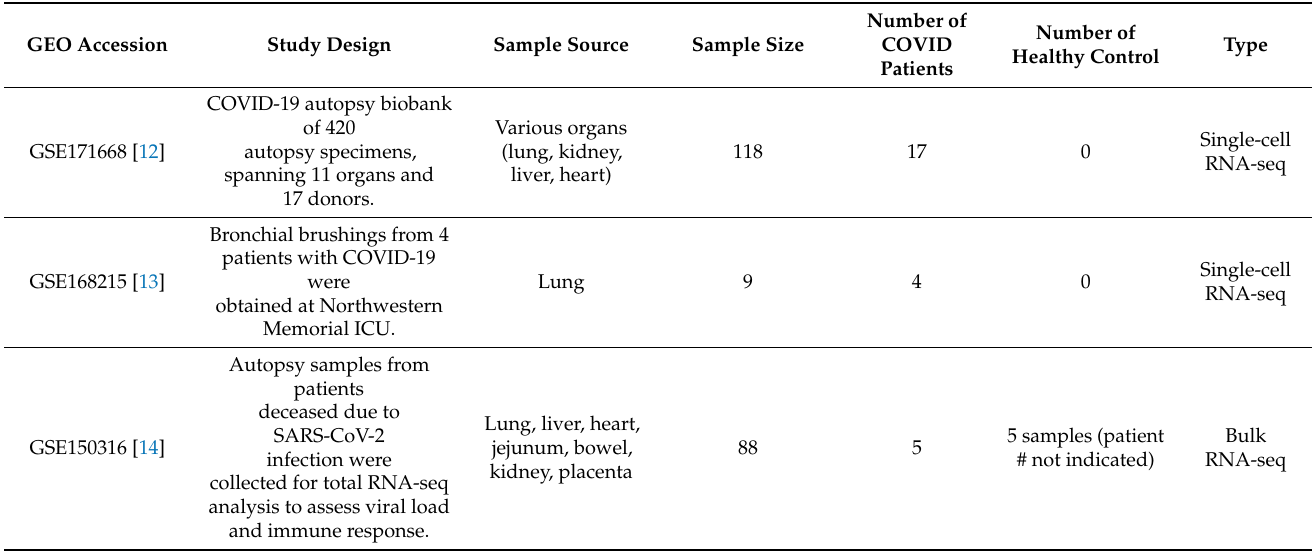
Table 1. RNA-seq datasets. Each publicly available dataset’s accession number, RNA-seq type, and information about each